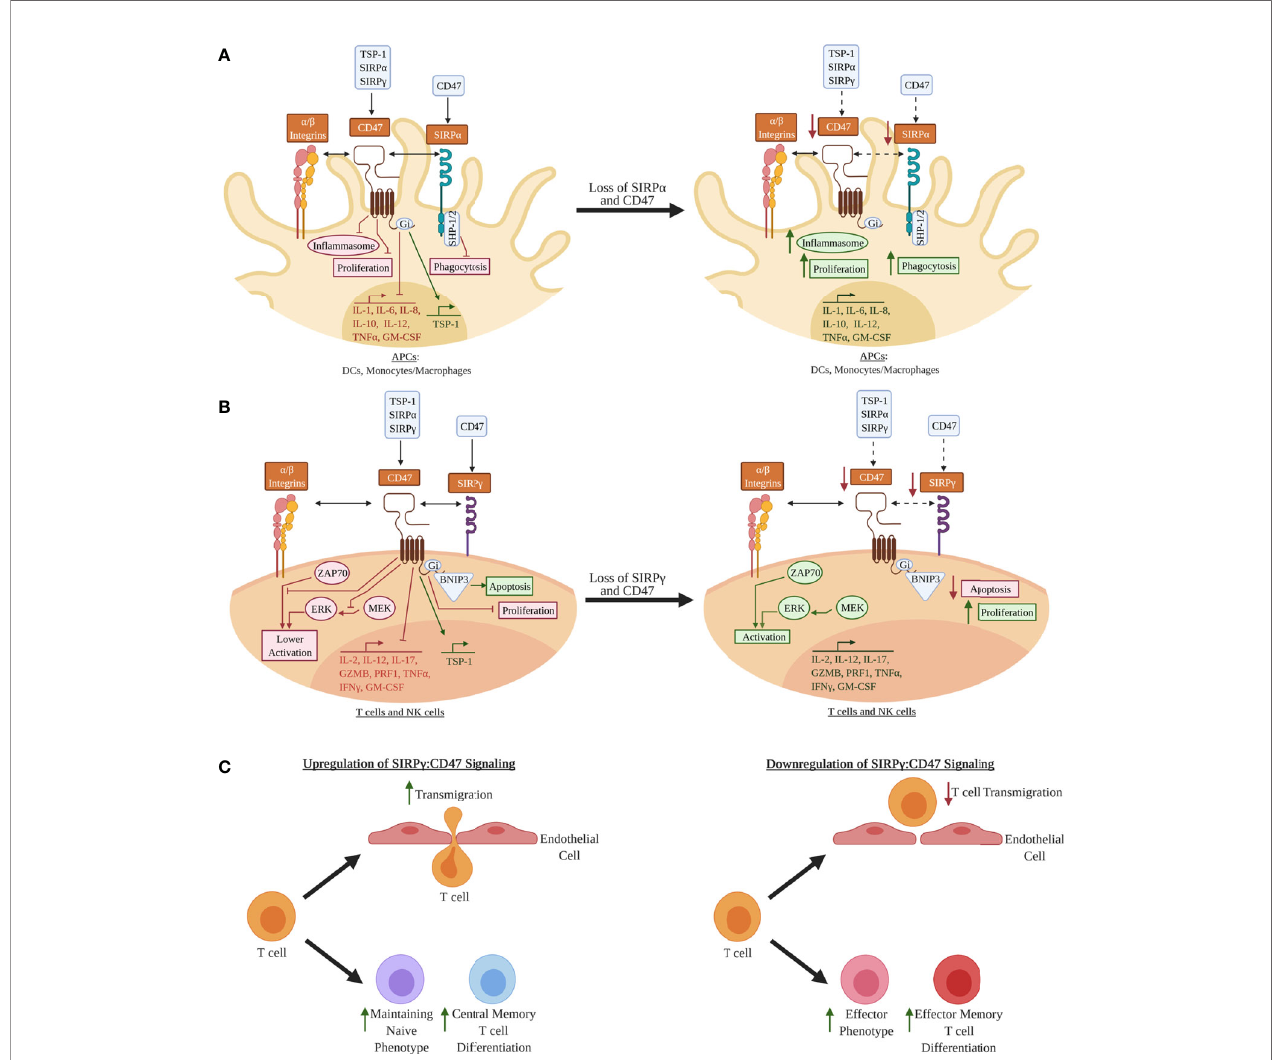
FIGURE 2 | Hypothetical model for how decreased SIRPs CD47 signaling may lead to a pro-in fl ammatory phenotype in leukocytes: (A) In antigen-presenting cells (APCs) such as dendritic cells (DCs) and monocytes/macrophages, signal regulatory protein alpha (SIRP a ) and CD47 are co-expressed, whereby SIRP a can bind CD47 expressed on other cell types (e.g., leukocytes, epithelial cells, endothelial cells) in trans or possibly via in cis interactions, thus activating the immunoreceptor tyrosine-based inhibitory motifs (ITIMs) on its cytoplasmic tail (5, 22, 23, 31, 32). CD47 is activated by either thrombospondin 1 (TSP-1), SIRP a , or SIRP g , where it is hypothesized that inhibitory G protein (Gi) binding inhibits in fl ammasome activation, pro-in fl ammatory cytokine expression, proliferation, and phagocytosis (25, 33). These processes may be augmented if SIRP a and/or CD47 expression are decreased. (B) SIRP g and CD47 are co-expressed in T and natural killer (NK) cells (5 – 7, 31). CD47 ligation is hypothesized to inhibit T and NK cell activation via inhibition of unknown downstream elements of the zeta chain of T cell receptor-associated protein kinase 70 (ZAP70) activation, inhibition phosphorylation of the mitogen-associated protein kinase (MEK), and inhibition of phosphorylation of the extracellular signal-regulated kinases (ERK) (26, 34 – 37). BCL2 interacting protein 3 (BNIP3) is a mediator of apoptosis that may be upregulated by activation of CD47 (24, 34, 38). Decrease expression of CD47 and/or SIRP g could potentially augment T cells and NK cells in a way that results in a more activated phenotype and increase proliferation in these immune cells. (C) Other examples of the effect of SIRP g :CD47 signaling in T cells. Upregulation of CD47 signaling is hypothesized to increase T cell transmigration; however, it is not known for sure if this increase in transmigration alters activation of the T cell (39, 40). CD47 ligation is also hypothesized to help maintain the naivety of T cells, and, once activated, promotes these T cells to differentiate to a more central memory phenotype (41 – 43). If loss of SIRP g :CD47 signaling occurs in T cells, it is hypothesized that this will contribute towards the differentiation to more effector and effector memory phenotypes along with a loss of transmigration. Red Text/Box: Inhibition; Green Text/Box: